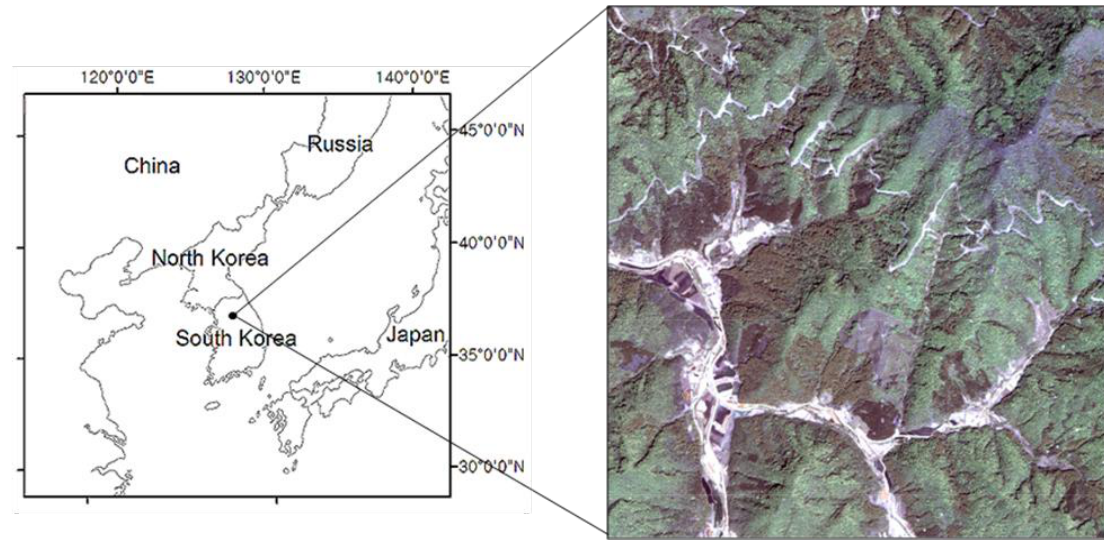
Figure 1. The study area with the pan-sharpened IKONOS